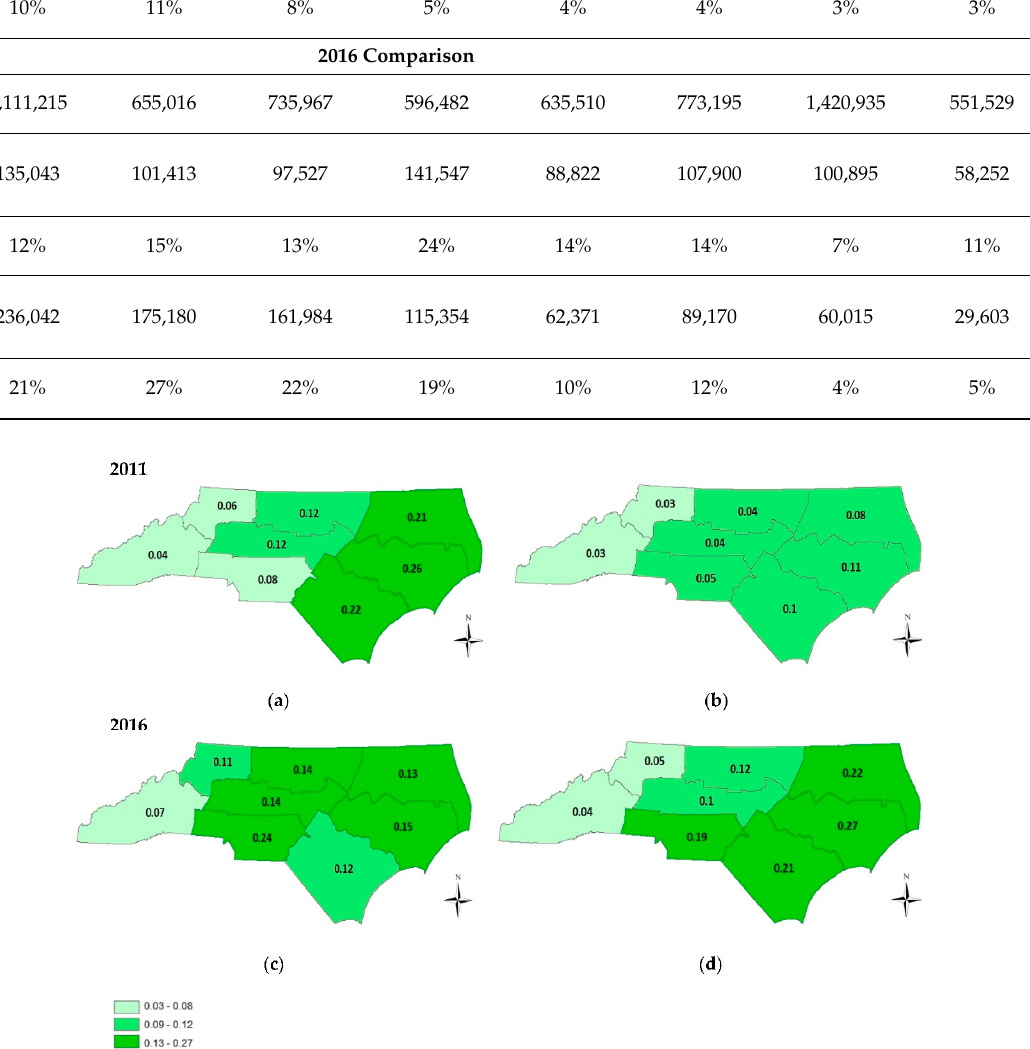
Figure 3. Mismatch as a percentage of match: ( a ) forestland in CDL, but something else in the NLCD in 2011; ( b ) forestland in the NLCD, but something else in CDL in 2011; ( c ) forestland in CDL, but Table 5. Correlation table showing the relationship between the share of forests and forestland mis- match.